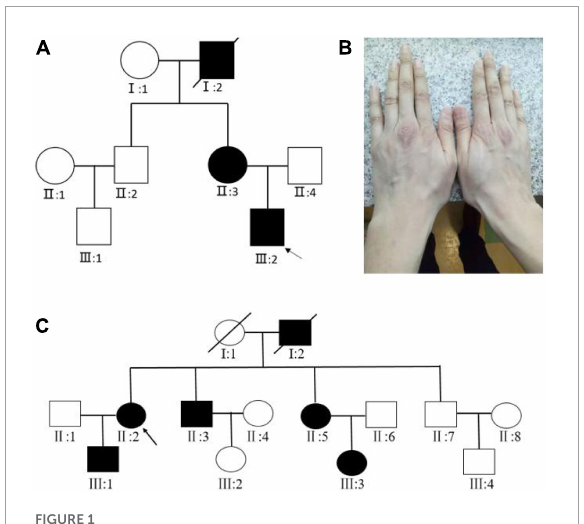
FIGURE1 (A) Pedigree map of Family 1. The arrow indicates the proband. Squares and circles symbolize males and females, respectively. Black and white denote affected and unaffected individuals, respectively. (B) The long fingers of the proband of Family 1. (C) Pedigree map of Family